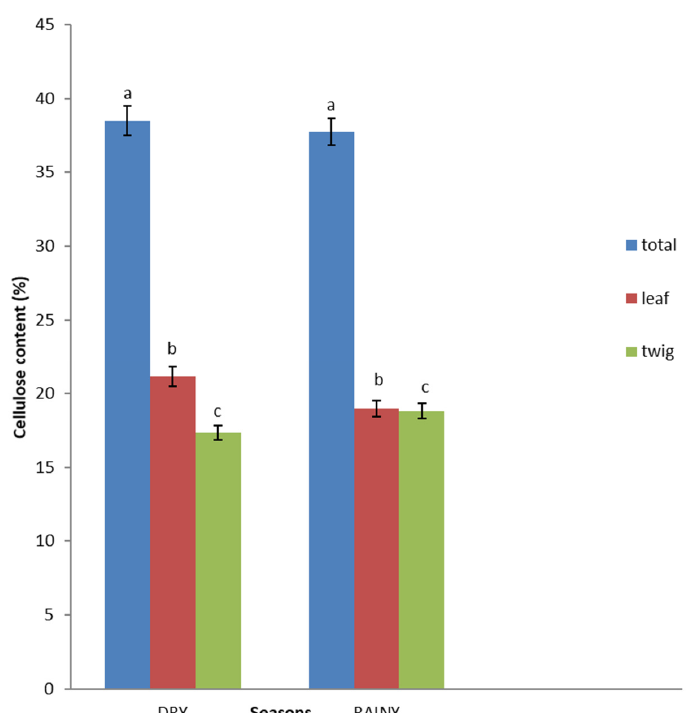
Figure 2b. Cellulose Content in the Litter Standing Crop of Bamboo at the Peak of Seasons in a regenerating forest, Ile-Ife *Vertical bars of the same alphabet in a month are not significantly (p > 0.05) different using Duncan Multiple Range Test